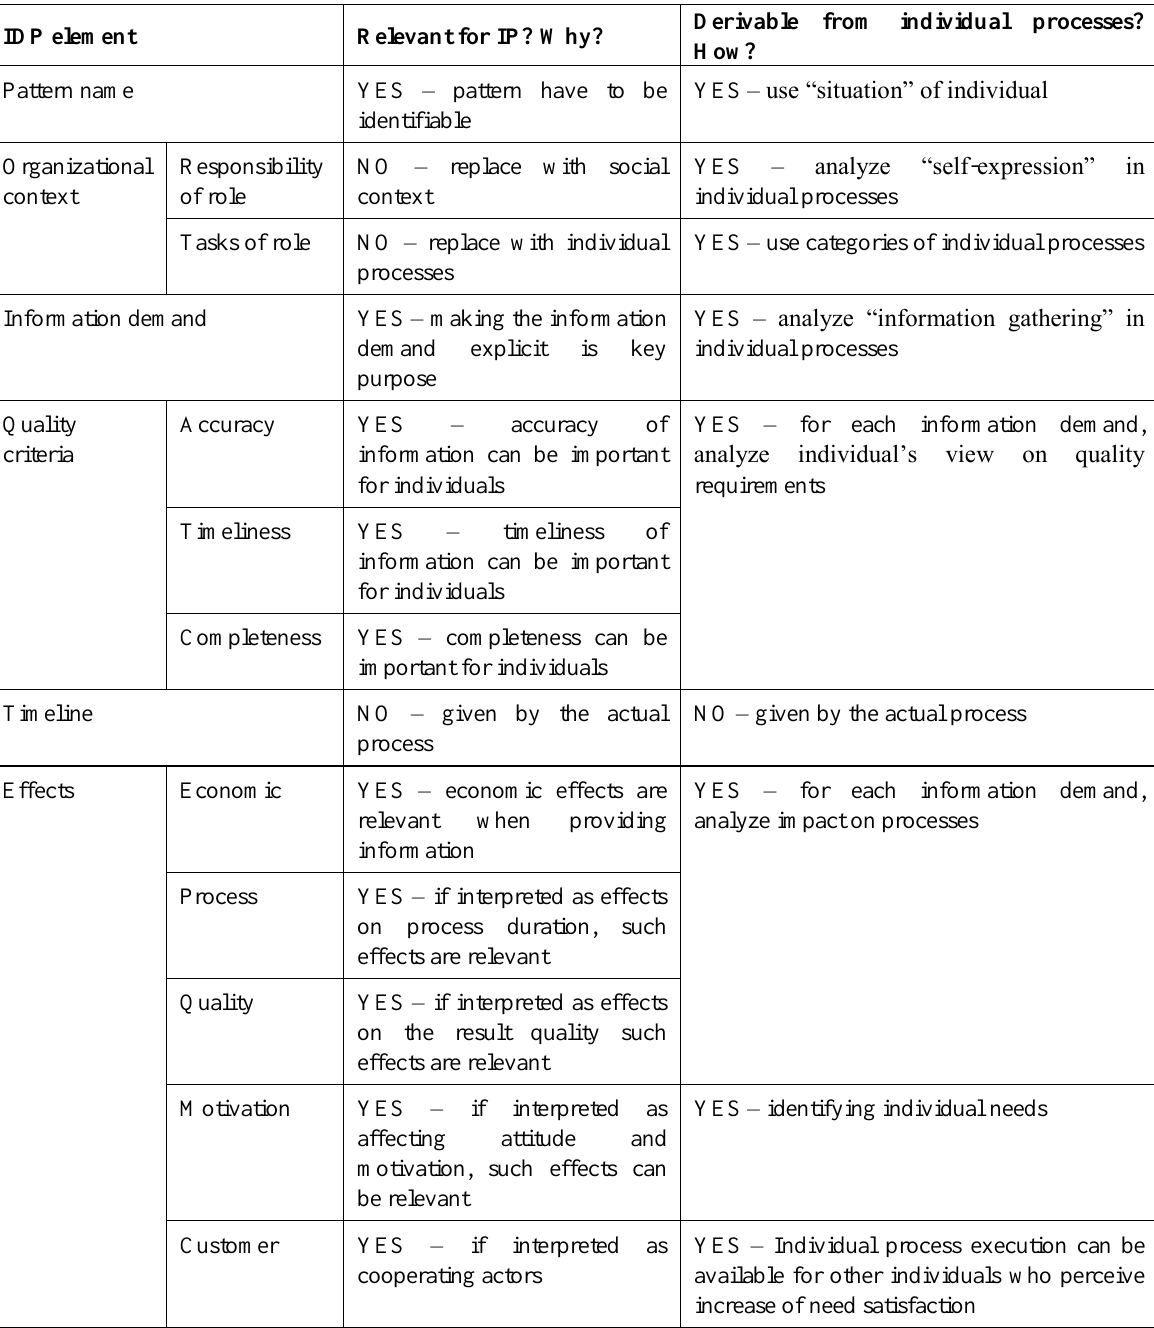
Table 1. Analysis of IDP structure regarding fitness for IP IDP